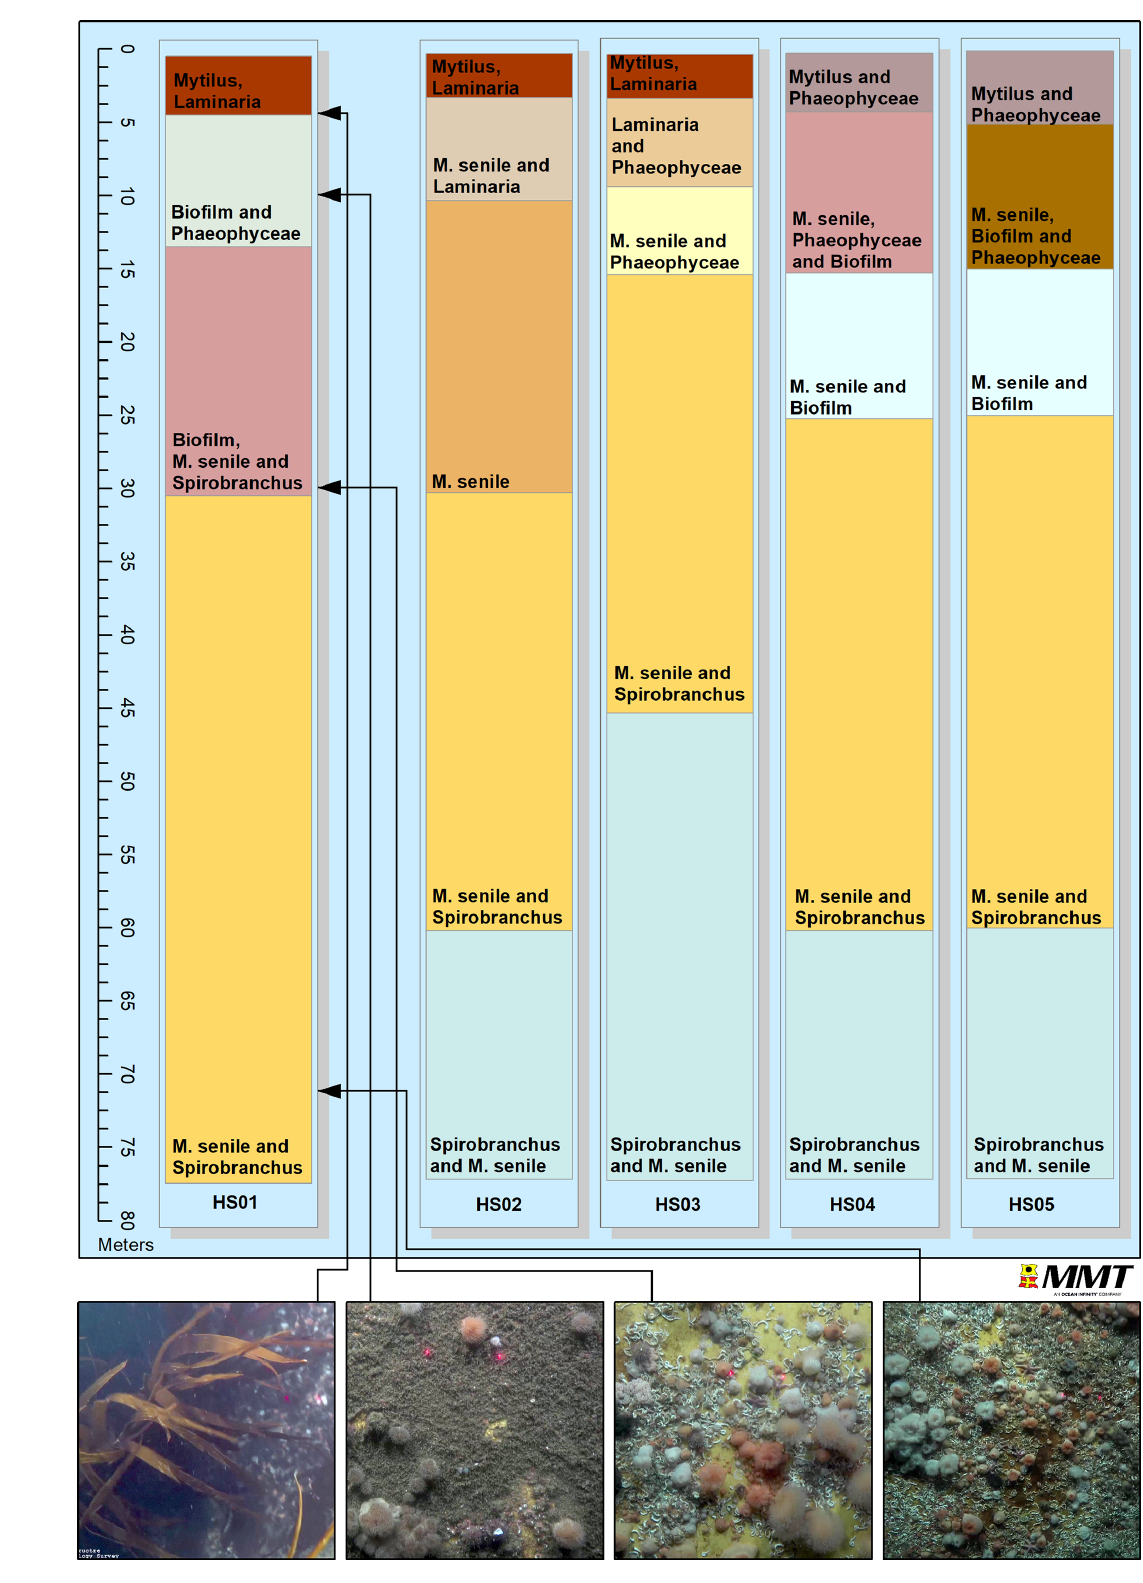
Figure 6. Illustration of faunal zonation at turbine substructures HS01–HS05. Order of taxa indicates dominance, with dominant taxa listed first.